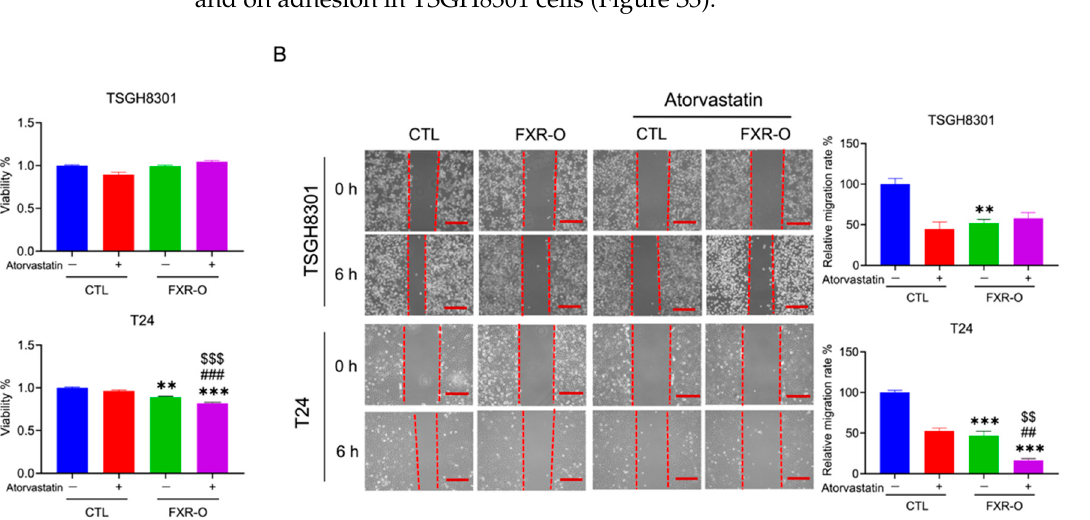
Figure 7. The effect of FXR overexpression combined with atorvastatin treatment on the invasion and angiogenesis of T24 cells. ( A ) Transwell invasion assays were performed in control and FXR-O